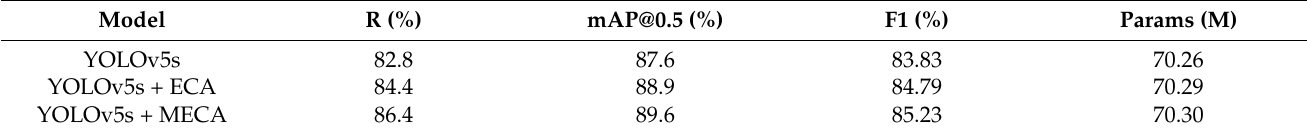
Table 3. Effect of different attention modules on model detection results.